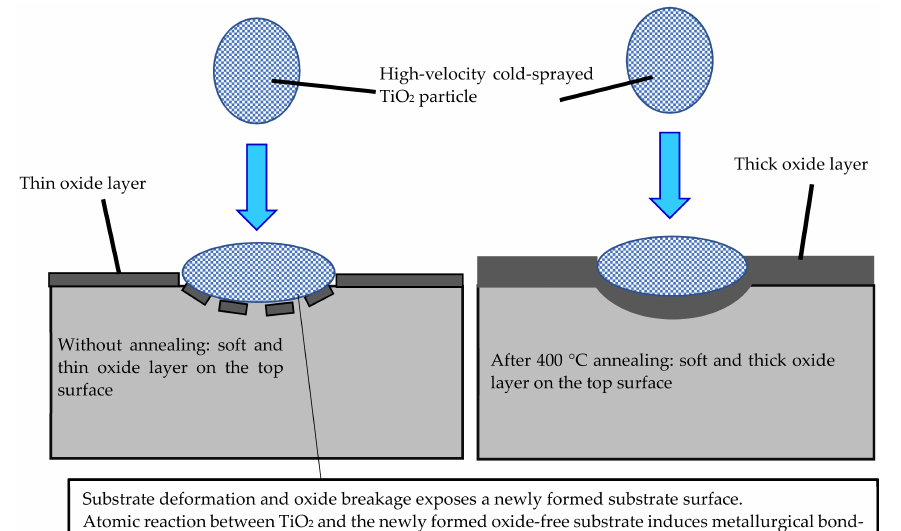
Figure 16. Schematic image of cold-sprayed TiO 2 deposition onto soft materials with thin and thick oxide